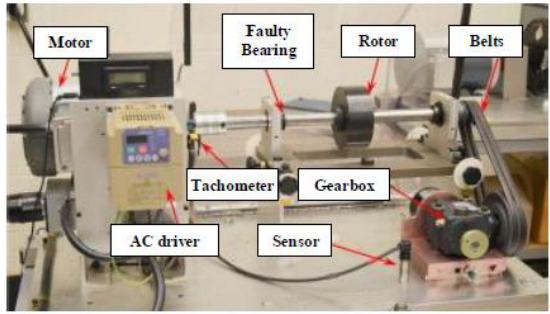
Figure 6. Experimental setup for outer race fault test. Table 1. Parameters of the bearings used in the test.